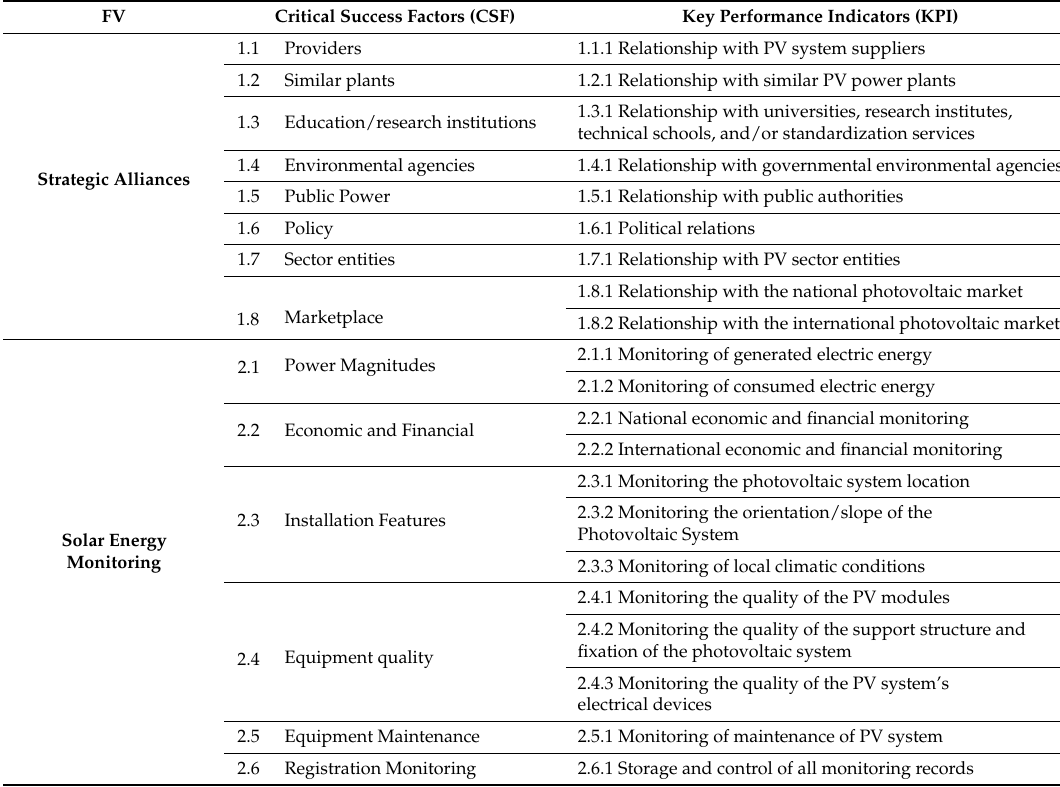
Table 1. Representation of Fundamental Viewpoints (FVs), Critical Success Factors (CSFs) and Key Performance Indicators (KPIs). FV Key Performance Indicators